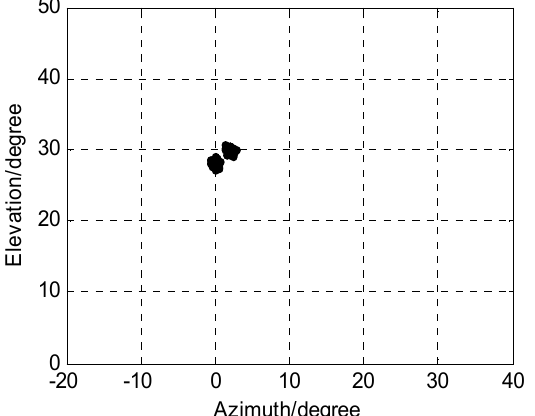
Figure 10. Angle estimation of our algorithm for closely spaced sources.